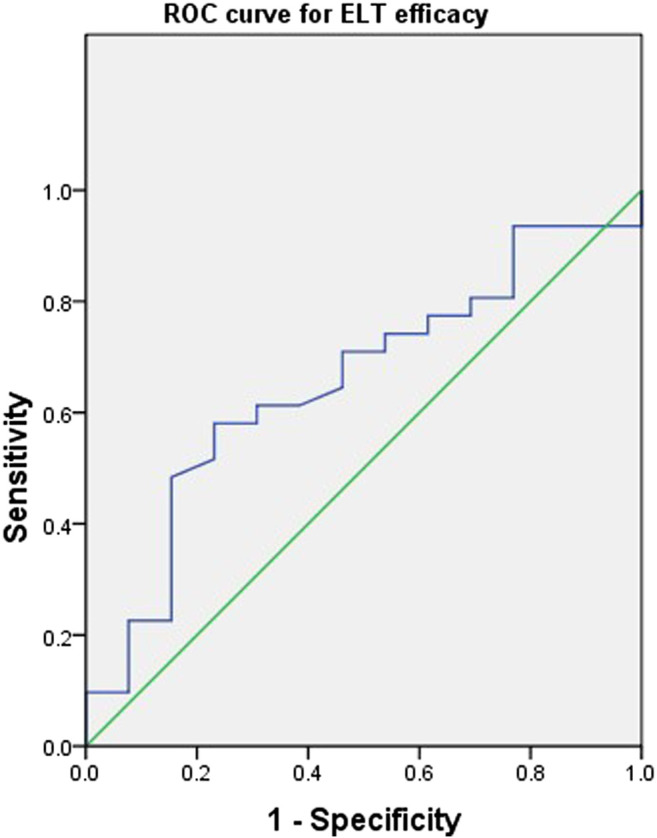
Receiver operating characteristic curves of the Eltrombopag concentration and efficacy for 44 patients with refractory nonsevere aplastic anemia. A plot of test sensitivity (y coordinate) vs. the false positive rate (x coordinate) was obtained at each cutoff level. The area under the smooth ROC curve and its 95% CI were 0.65 and 0.48–0.83, respectively.